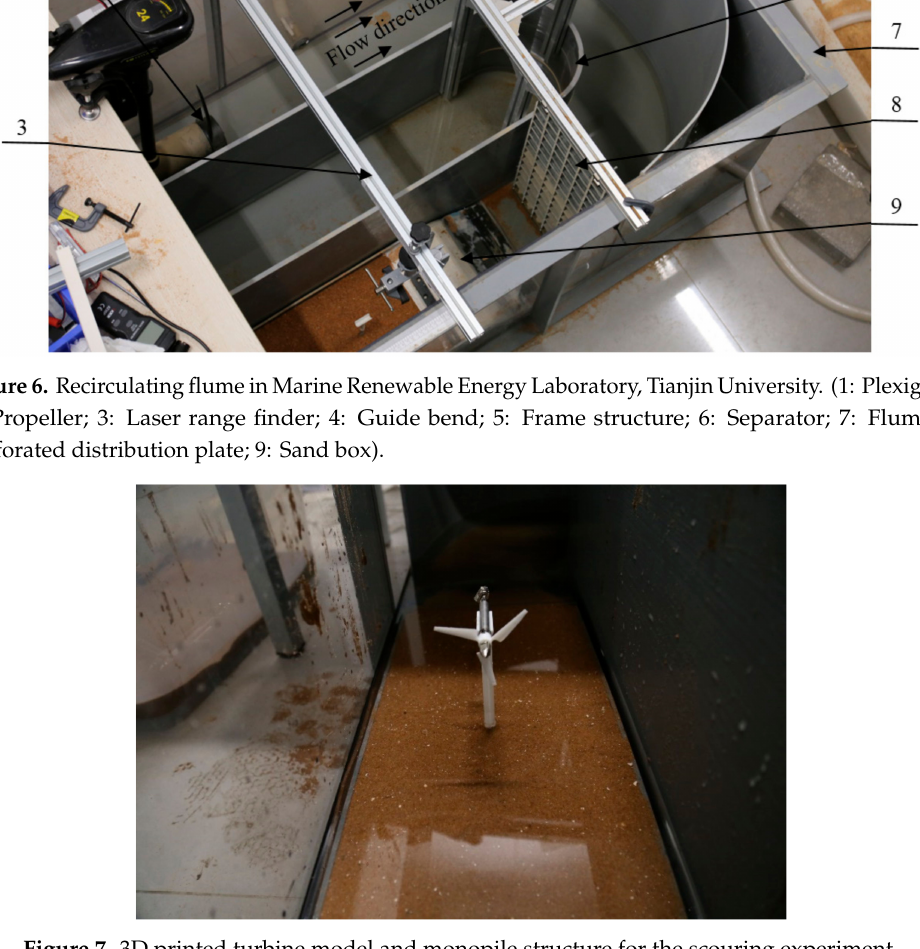
Figure 7. 3D printed turbine model and monopile structure for the scouring